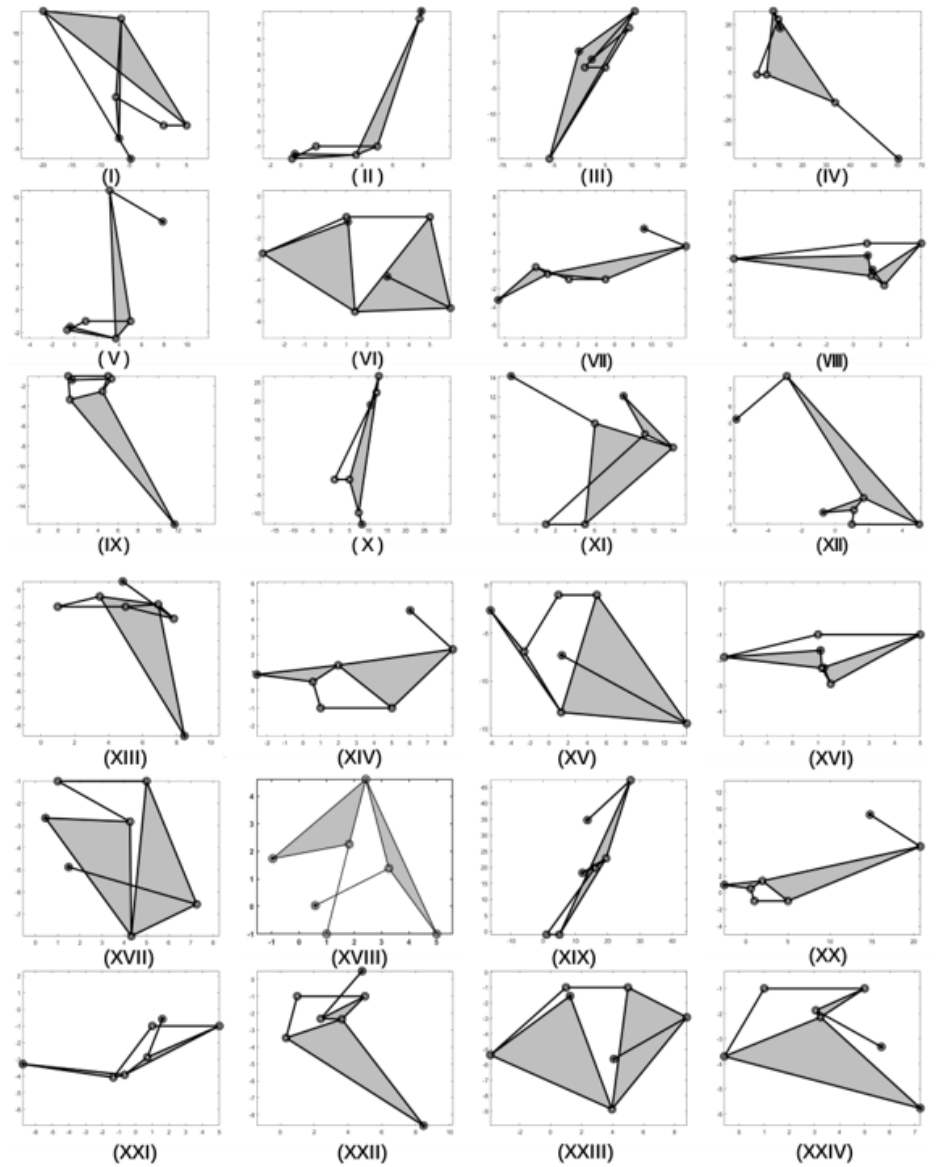
Figure 5. The configurations of the selected results.